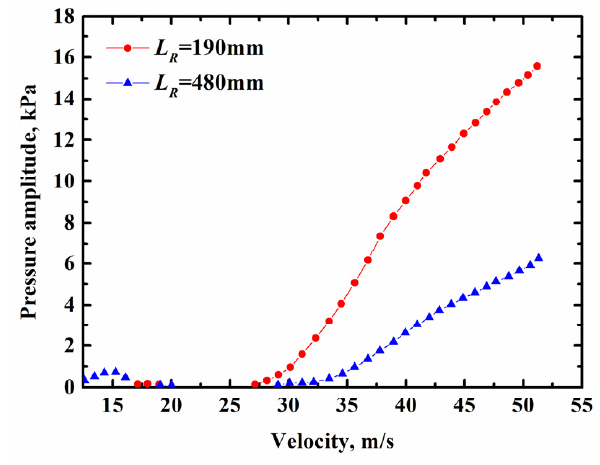
Figure 5. Pressure amplitudes at the closed end of cavity varying with flow velocity.